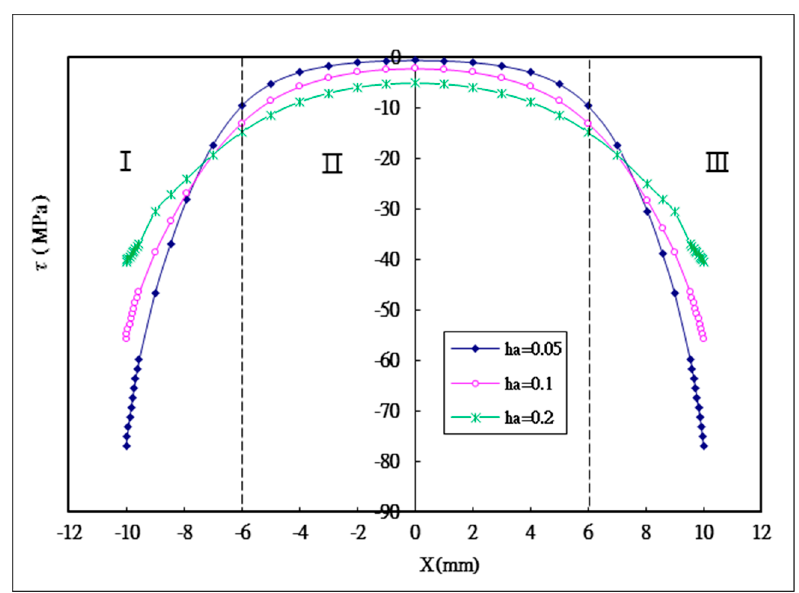
Figure 7. Shear stress distribution in the adhesive with three different adhesive thicknesses.